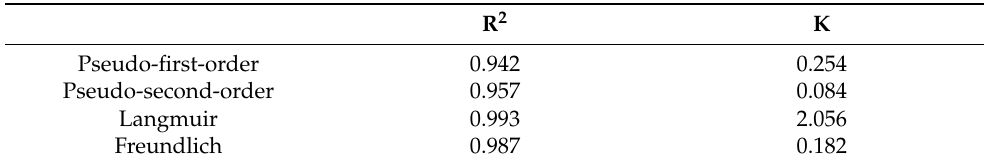
Figure 8. Kinetic fitting diagram ( a ) and thermodynamic fitting diagram ( b ) of adsorption of azlocillin sodium by MIL- 53/D201 composite. Table 2. Kinetic fitting parameters and thermodynamic fitting parameters of azlocillin sodium ad- sorption by MIL-53/D201 composite.